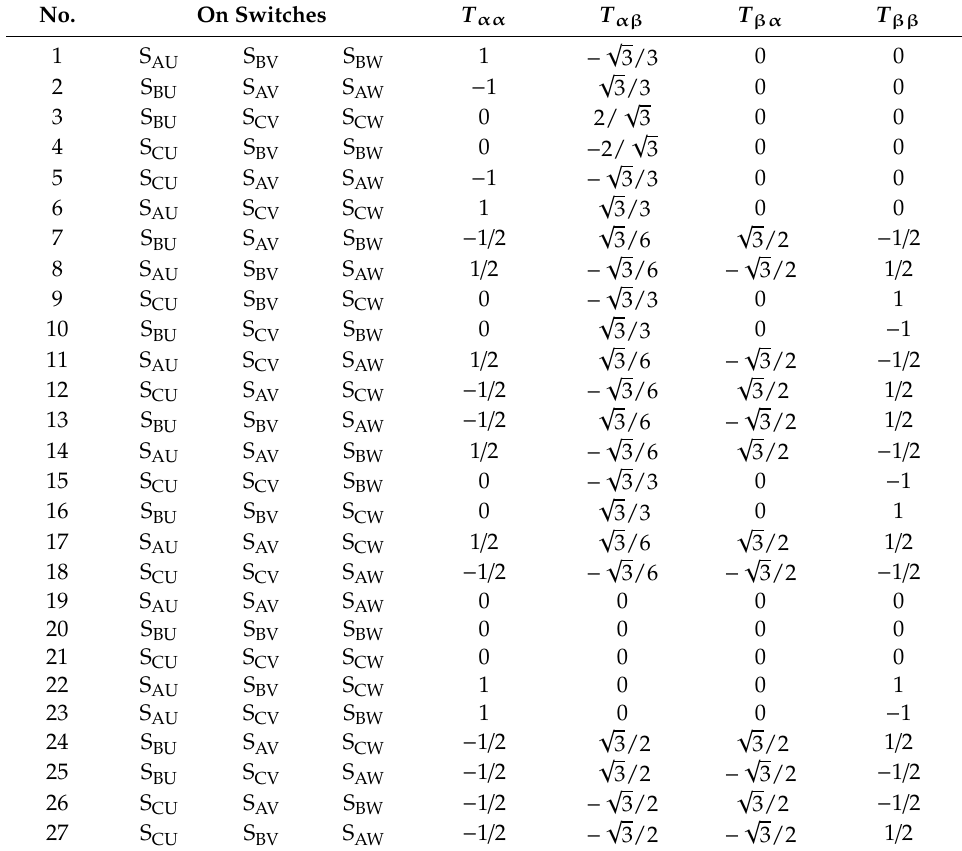
Table 1. Valid switching states of the